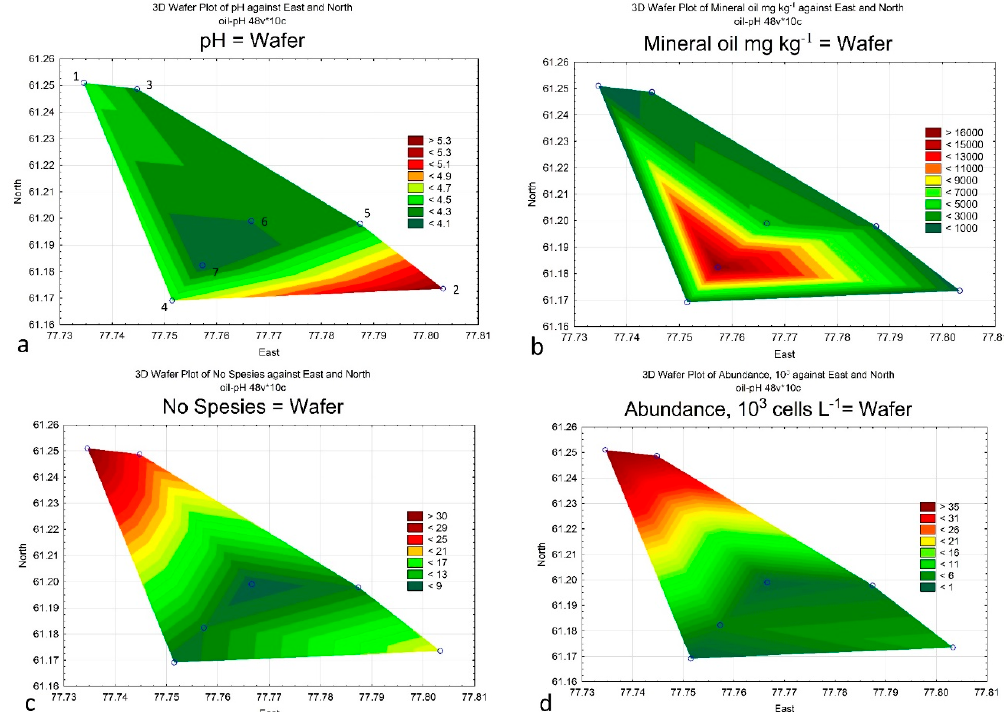
Figure 3. Distribution maps for water pH ( a ), mineral oil ( b ), species richness ( c ), and algal abundance ( d ) in seven studied sites of the bogs of the Ershov oil field in the Vakh River basin of the KMAO- Yugra.